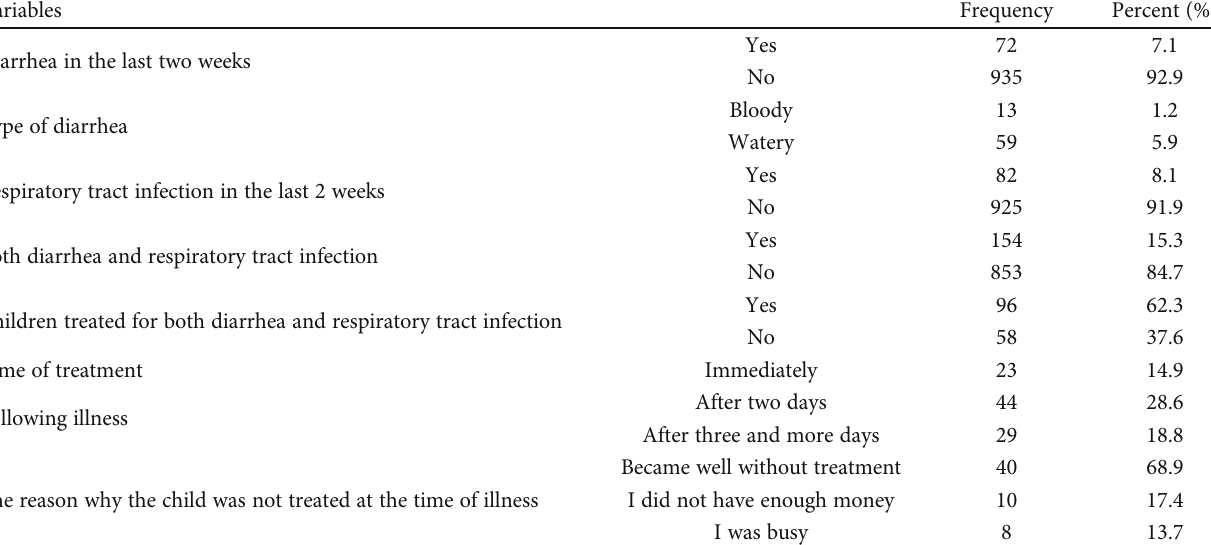
Table 3: Illness characteristics among children aged 24-59months in Lay Armachiho District, Central Gondar Zone, northwest Ethiopia,